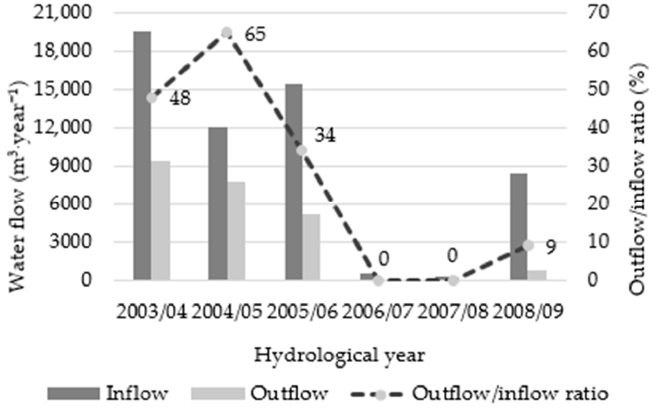
Figure 3. Water balance of the monitored SFCW.